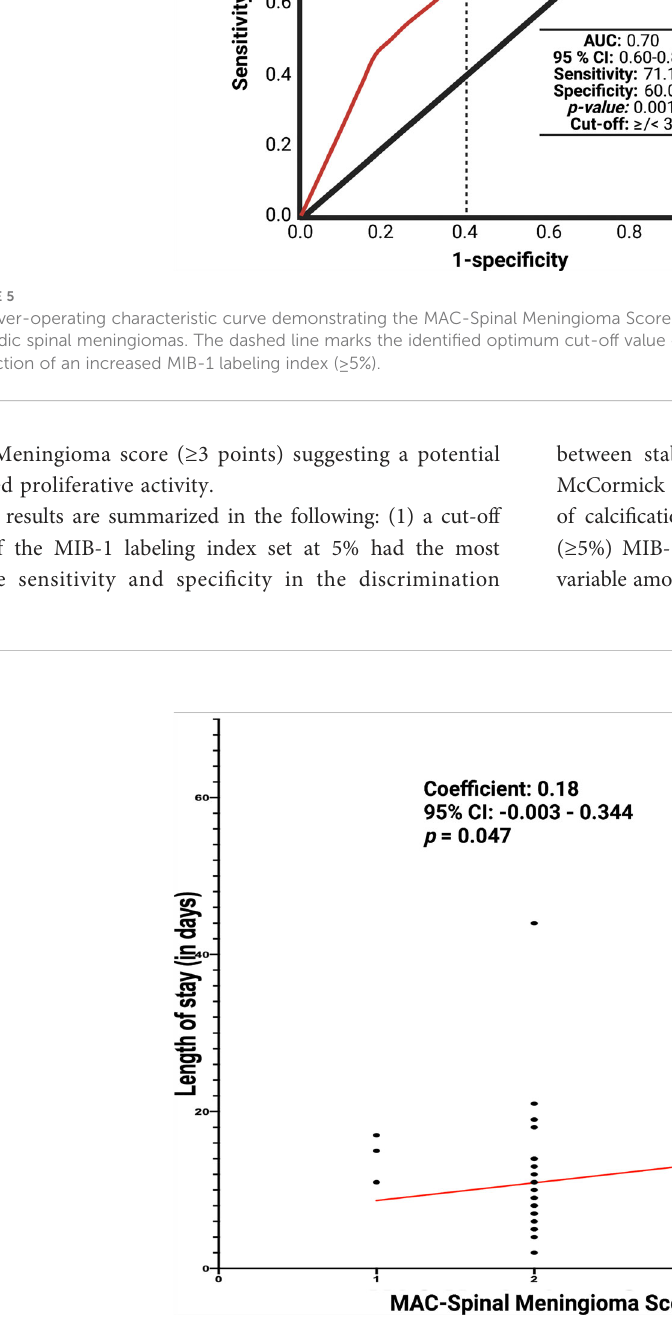
FIGURE 6 Length of stay (in days) in relation to the MAC-Spinal Meningioma Score of 128 primary sporadic spinal meningiomas.